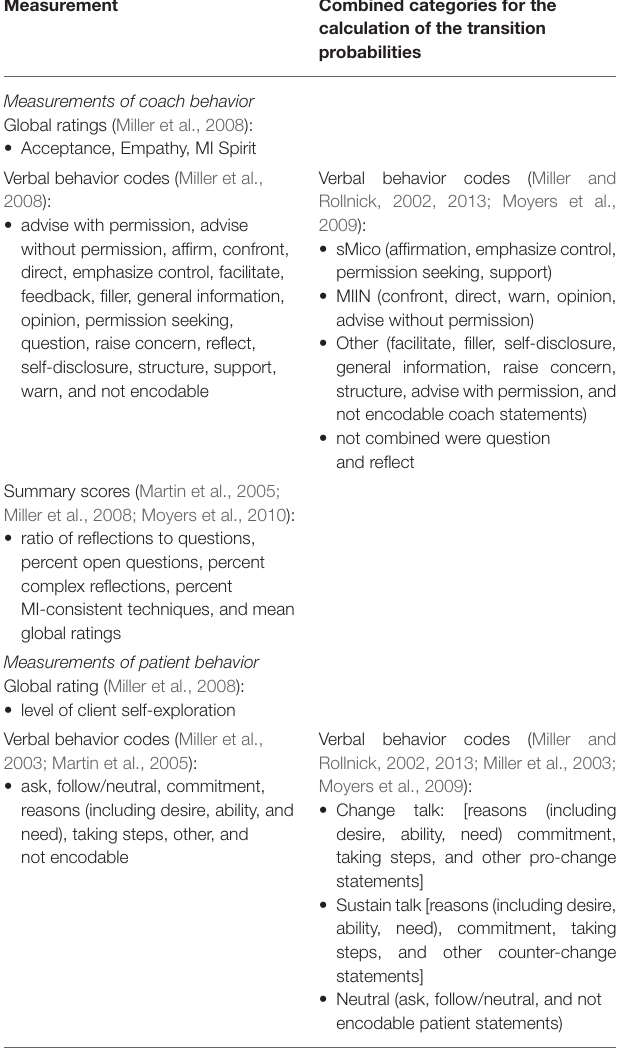
TABLE 3 | Measurement of coach and patient